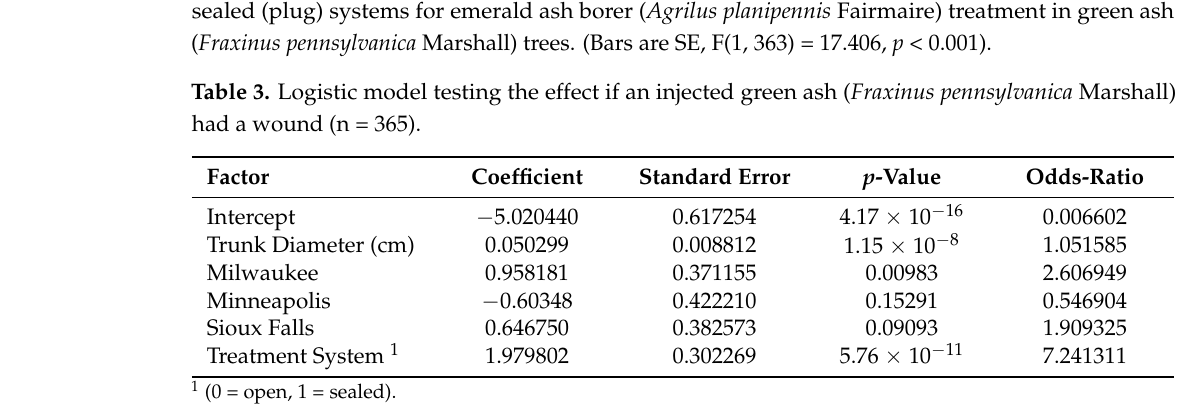
Table 4. Linear regression model testing the effect on the number of wounds per tree with injected